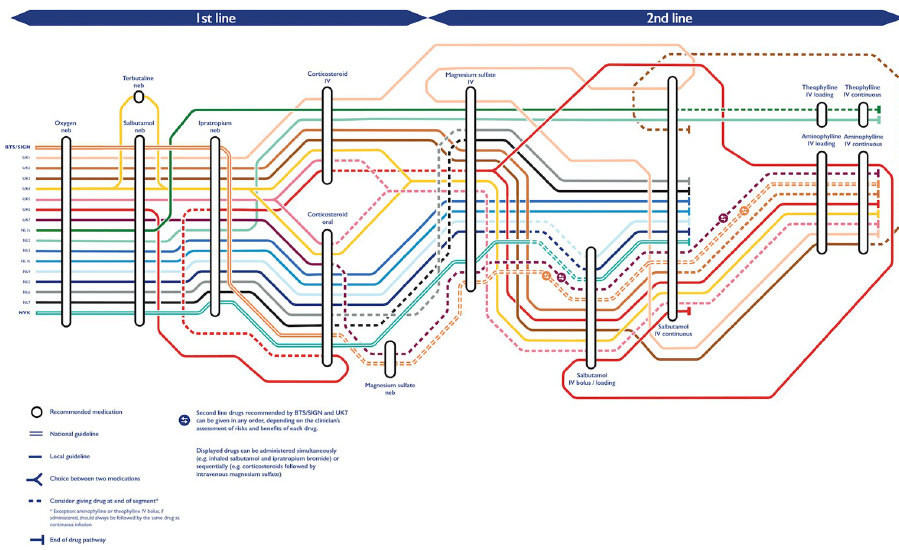
Fig 1. Variation across treatment pathways for most severe acute paediatric asthma across British and Dutch CPGs. Drug recommendations proceed from left to right. Iv: intravenous, neb: nebulized.